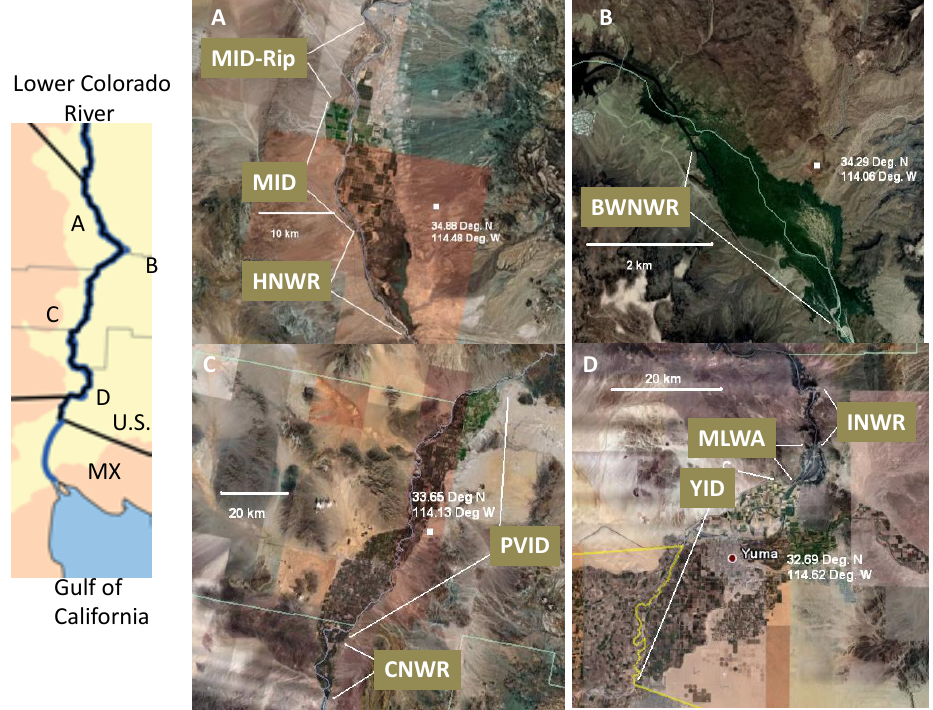
Figure 1. Wide area riparian and agricultural areas for which ET was estimated on the Lower Colorado River. MID-Riparian = riparian zone north of Mohave Irrigation District (MID); HNWR = Havasu National Wildlife Refuge; BWNWR = Bill Williams National Wildlife Refuge; PVID = Palo Verde Irrigation District; CNWR = Cibola National Wildlife Refuge; INWR = Imperial National Wildlife Refuge; MLWA = Mittry Lake Wildlife Area; YID = Yuma Valley Irrigation District agricultural fields (images from